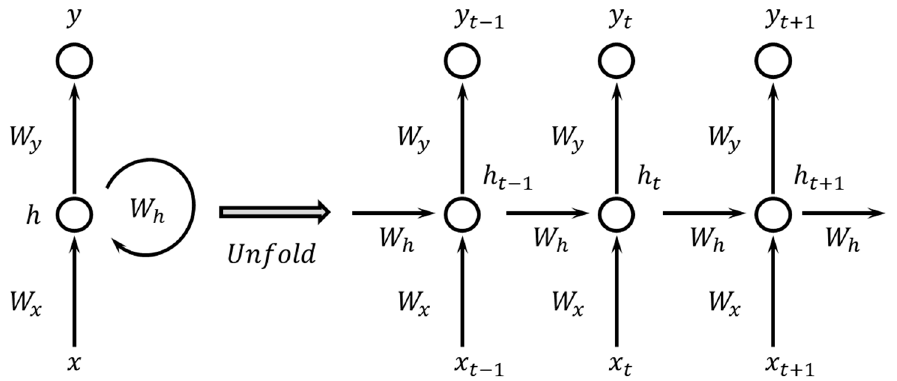
Figure 2. Recurrent neural network structure.